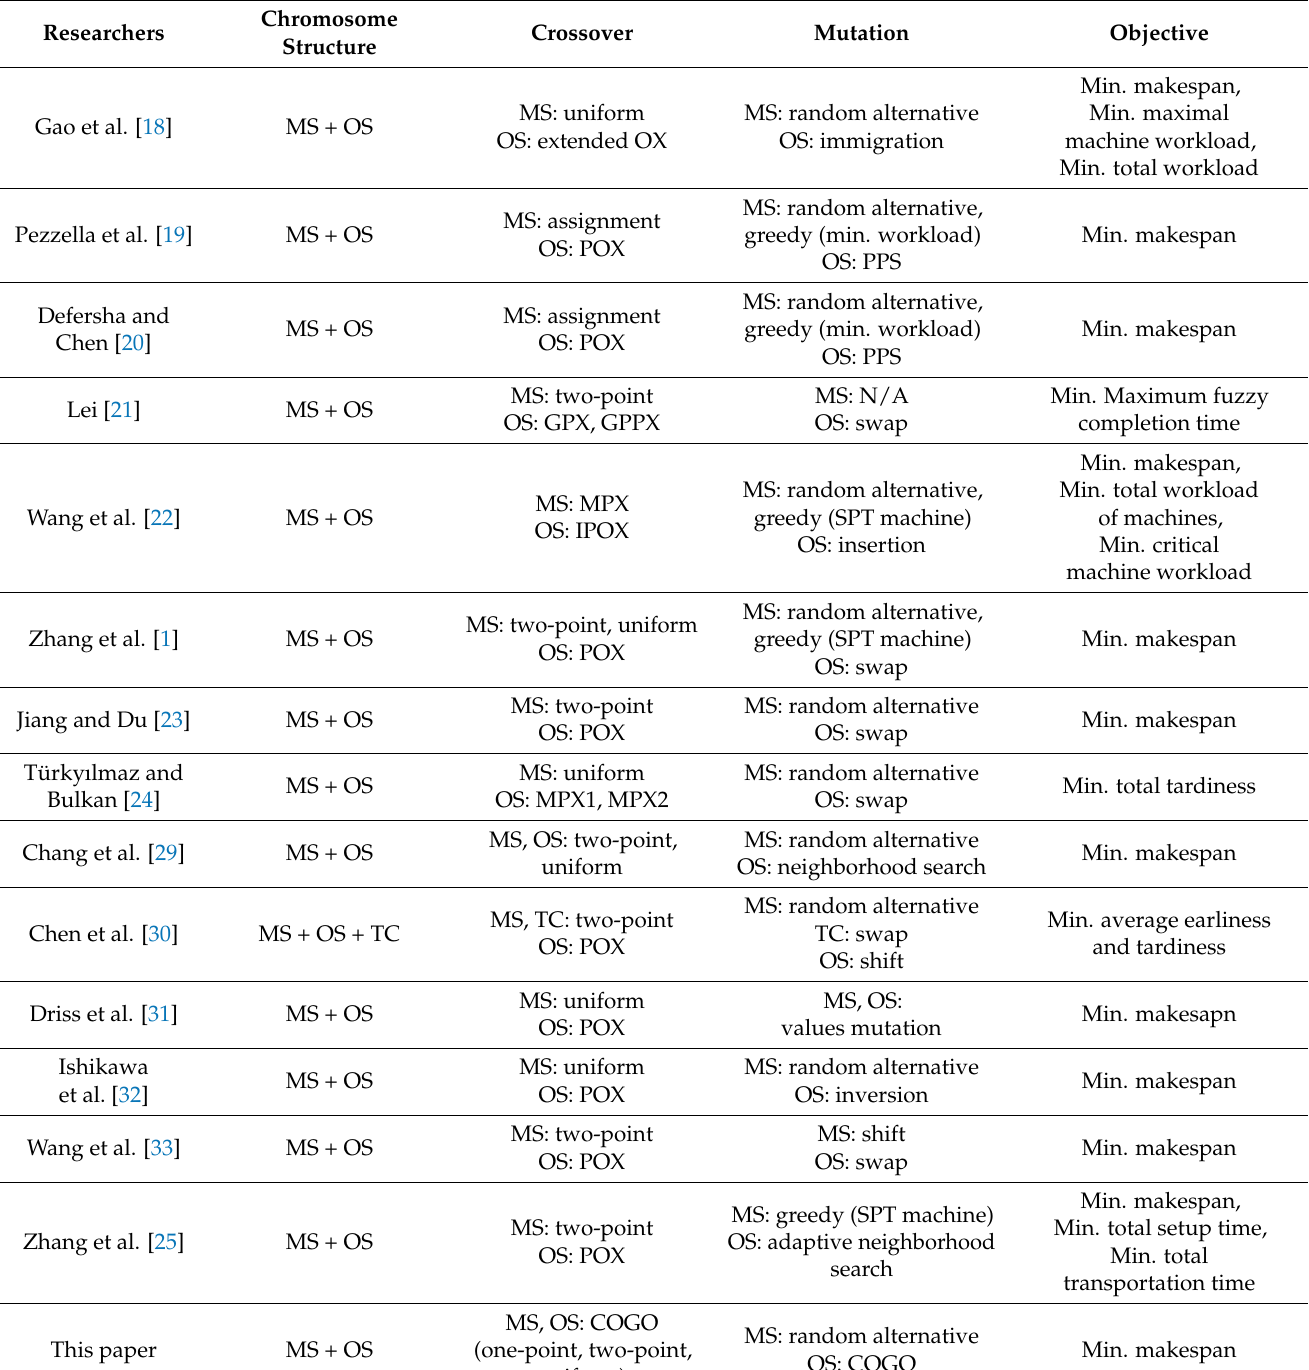
Table 1. Existing GAs for solving the